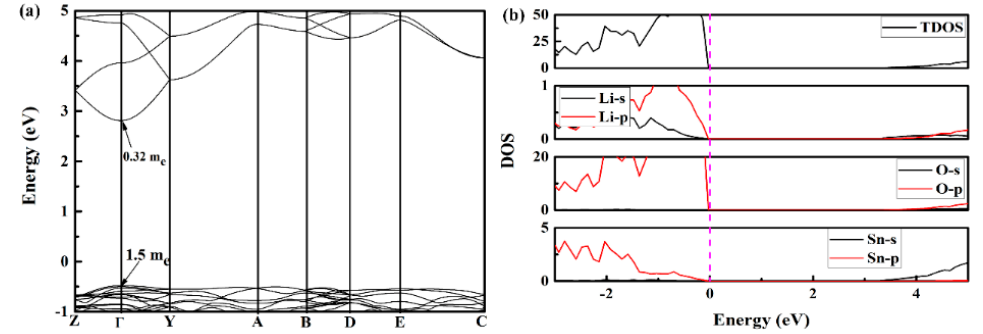
Figure 9. Calculated ( a ) band structure and ( b ) density of states of Li 2 SnO 3.